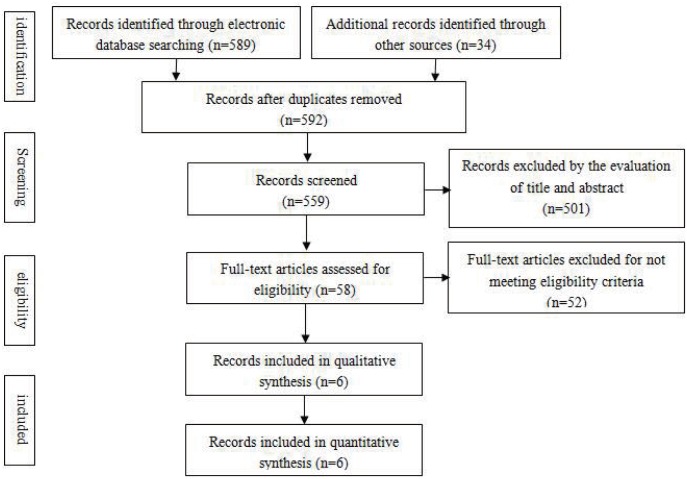
Flow diagram of the study selection process.Flow chart of number of studies identified and included into the review.